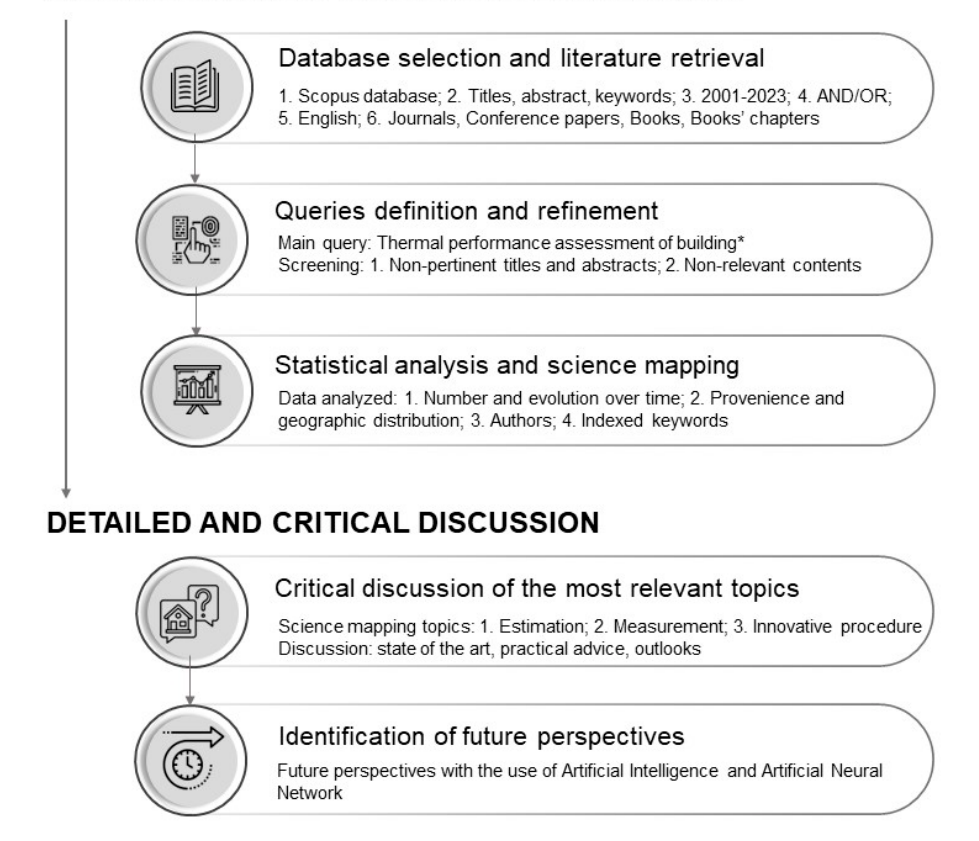
Figure 1. Flowchart of the research methodology (source: authors’ elaboration).